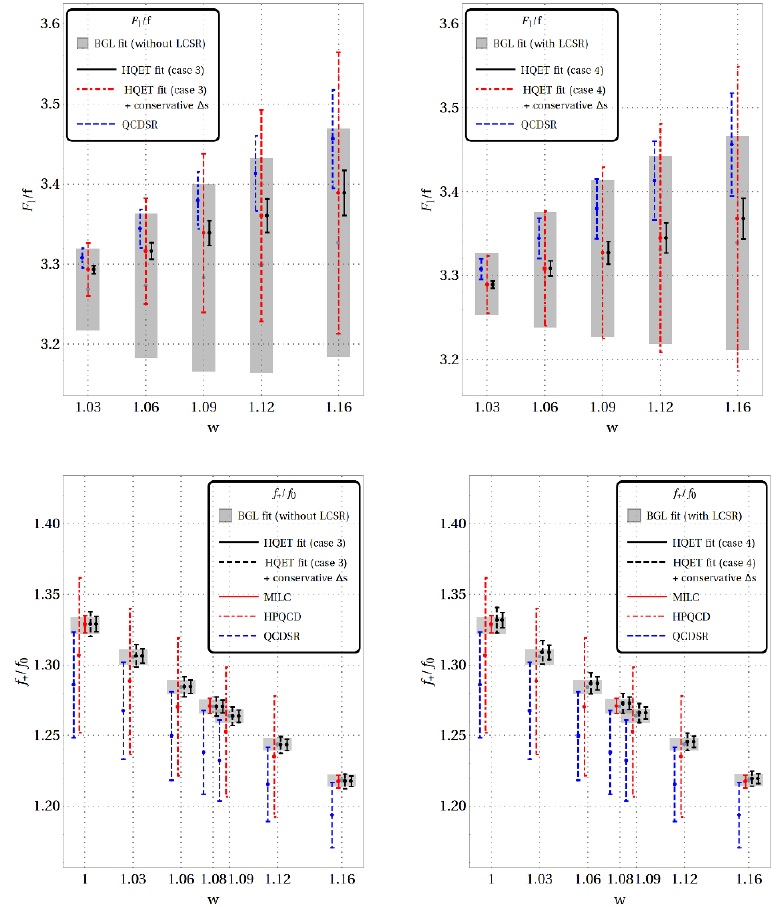
Figure 2 . Upper half panel: comparisons between di(cid:11)erent (cid:12)t results of F 1 ( w ) =f ( w ) (1 (cid:27) bars) with (right) and without (left) the inputs from LCSR. Lower half panel: the ratio f + =f 0 obtain from di(cid:11)erent (cid:12)ts, and from lattice. The (cid:12)t results are also compared with the QCDSR predictions. coming from the lattice results, in particular from the MILC collaboration, on f Apart from the high w values, the BGL (cid:12)t results of F of QCDSR predictions. However, the same ratios obtained using the HQET (cid:12)t parameters are marginally consistent with the QCDSR